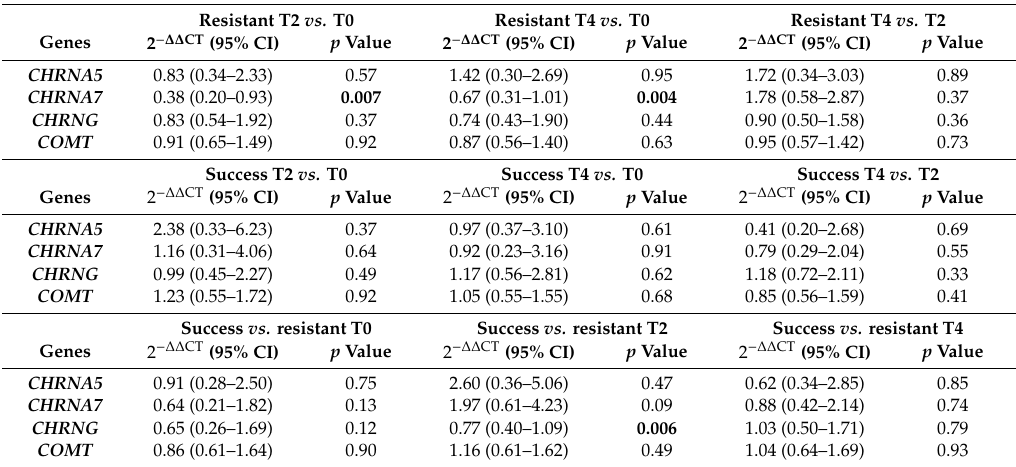
Table 2. Fold change and association analysis between time periods and outcome